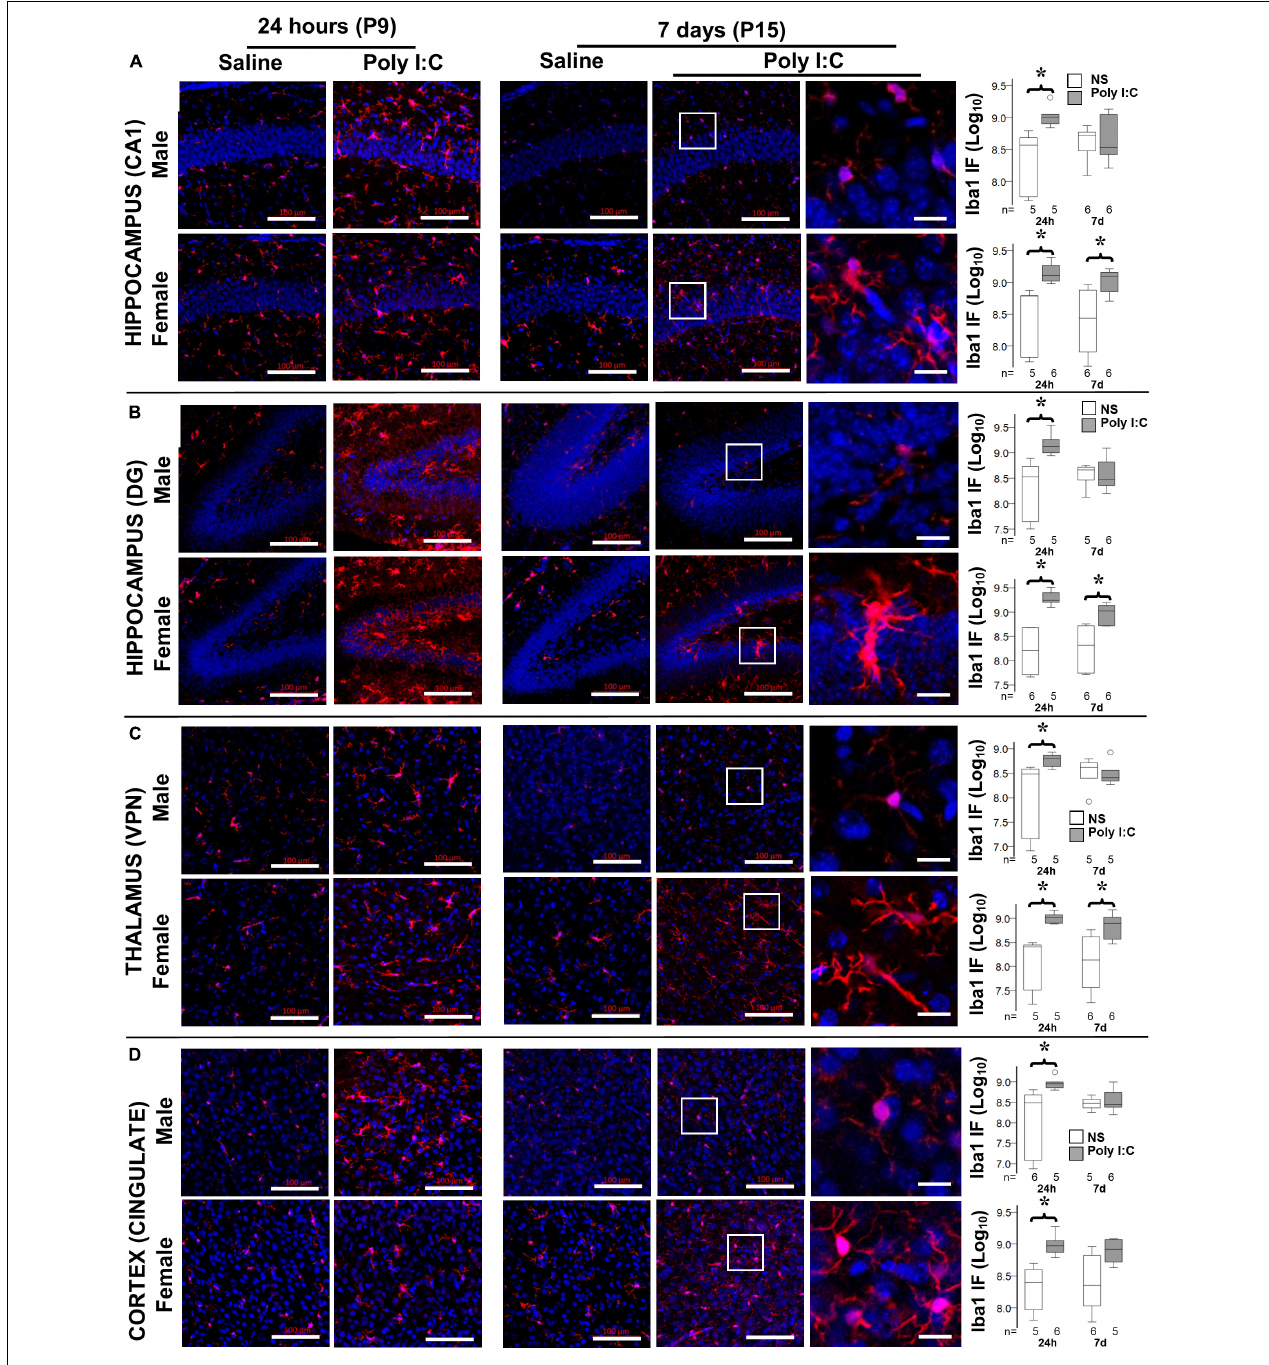
FIGURE 4 | Temporal changes in microglia activation after poly I:C exposure at P8. Representative photomicrographs of Iba1 immunofluorescence in the CA1 (A) and dentate gyrus (DG, B ) subfields of the hippocampus, VPN of the thalamus (C) , and cingulate cortex (D) of male (top row) and female mice (bottom row) at 24 h and 7 days after treatment with normal saline (NS) or poly I:C. High magnification datails show at 7 d after poly I:C. In all panels, bar represents 100 µ m, with the exception of the detail high magnification panels for 7 days after poly I:C, where bar represent 20 µ m. Semi-quantitative analyses of Iba1 immunofluorescence per sex and region of interest are shown using box and whiskers plots, where boxes are limited by the 75 th and 25 th percentiles (IQR) and whiskers are limited by the last data point within 1.5 times the IQR from the median (continuous line inside the box). Data from male (top) and female (bottom) mice at 24 h and 7 days after treatment with NS (white boxes) or poly I:C (gray boxes) are shown. Data are presented as the decimal logarithmic transformation of the total immunofluorescence signal in arbitrary units. ◦ , outlier (between 1.5 and 3 times the IQR); • , extreme ( > 3 times the IQR); ∗ p < 0.05 ( n = 4–6/group). Twenty-four hours after poly I:C, significant microglia activation was observed in all regions in both sexes. At 7 days after poly I:C, microglia activation significantly diminished in male mice (top), while persisted in all brain regions in female mice (bottom). Detailed information about immunofluorescence provided in Table 3 .